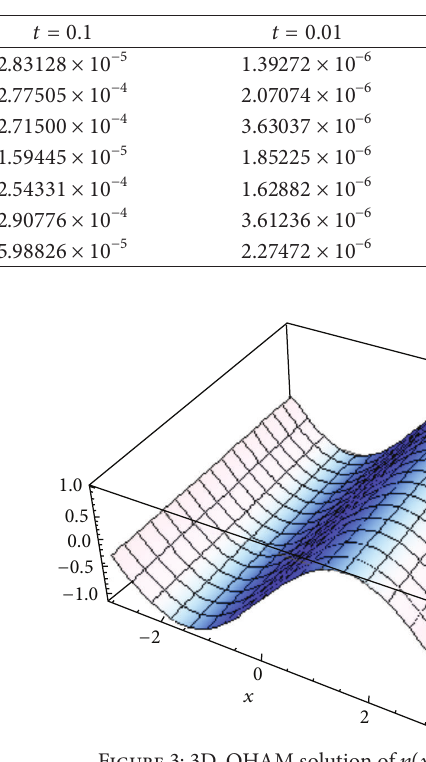
Table 2: Absolute error of OHAM solution 𝜂(𝑥, 𝑡) corresponding to the exact solution.